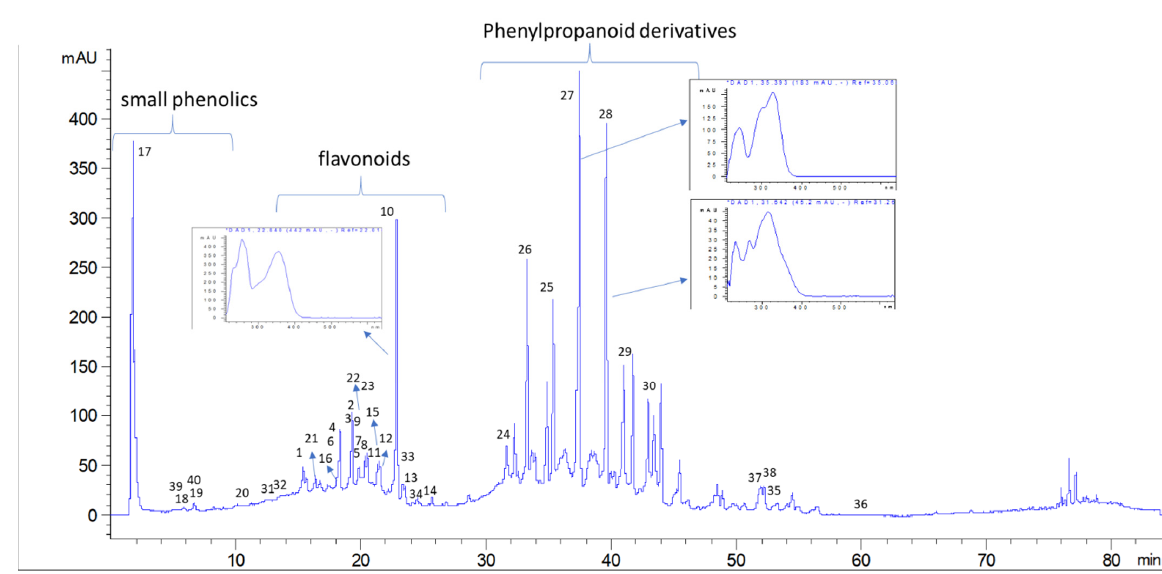
Figure 4. LC-DAD chromatogram (330 nm) showing the peak group assigned to small phenolics, flavonoids, and phenylpropanoid derivatives; exemplificative UV spectra of the peaks are included. Peaks numbers refer to Table 2.